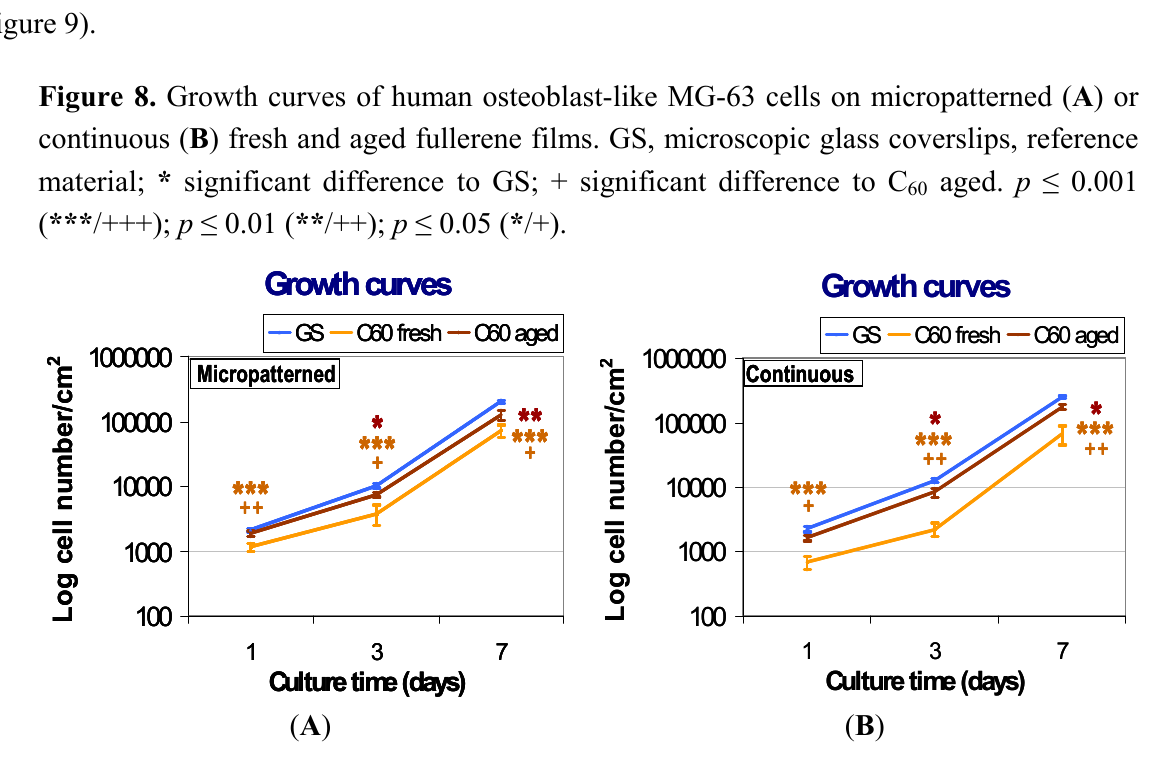
aged. p ≤ 0.001 60